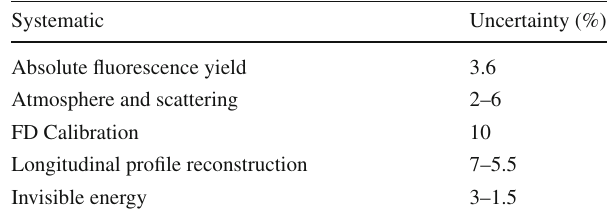
Table 4 The systematic uncertainties on the FD energy scale are given below. Lines with multiple entries represent the values at the low and high end of the considered energy range ( (cid:2) 10 17 and (cid:2) 10 19 eV,